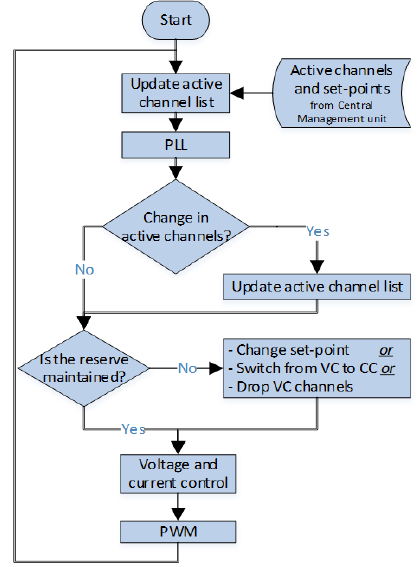
Figure 5. The flowchart of multi-channel operation scheme.